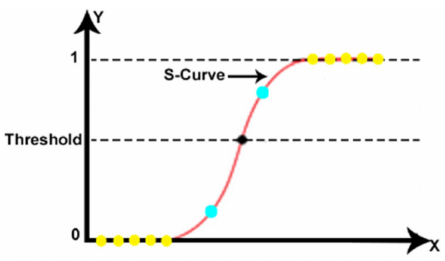
Figure 4. Example of the logistic